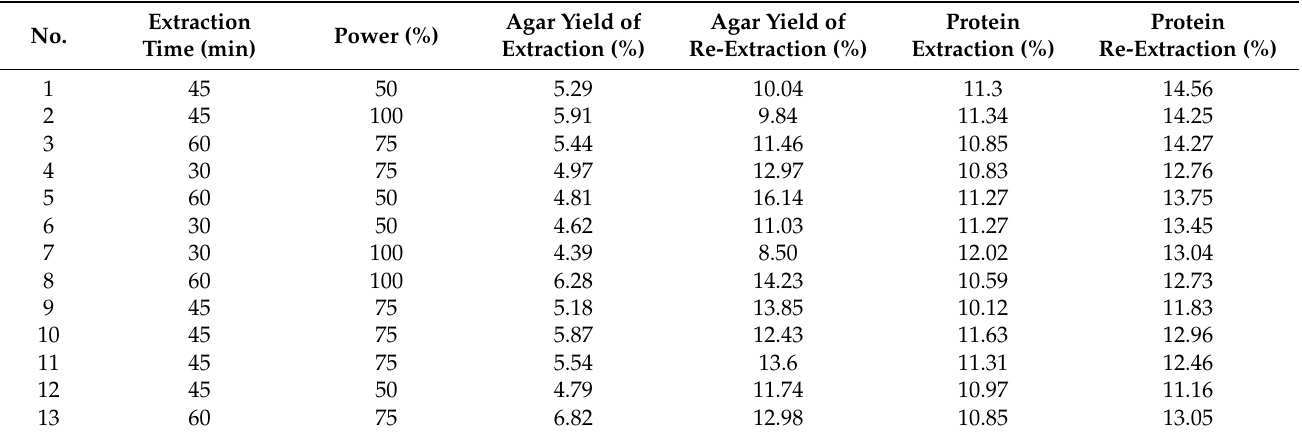
Table 2. Response surface central composite design (coded and uncoded) and the results for the ultrasound-assisted extraction and re-extraction yield of